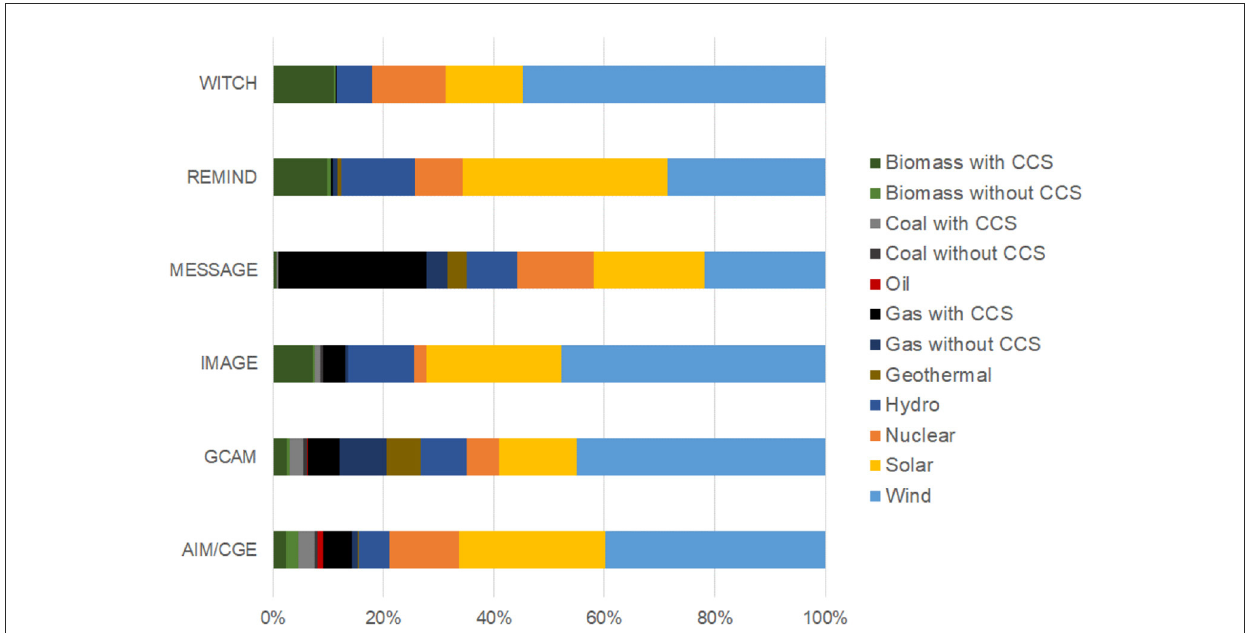
FIGURE1 Share of 2050 electricity generation by model type in SSP1-1.9 scenario for OECD region. SSP1 is a socio-economic storyline emphasizing a “green growth” paradigm (Van Vuuren et al., 2017), whilst SSP1-1.9 is a set of scenarios that achieve an approximate 1.9 W/m 2 radiative forcing by 2100, in line with the achievement of a 1.5 ◦ C limit to global warming (Rogelj et al., 2018). Source: SSP database (Riahi et al., 2017).